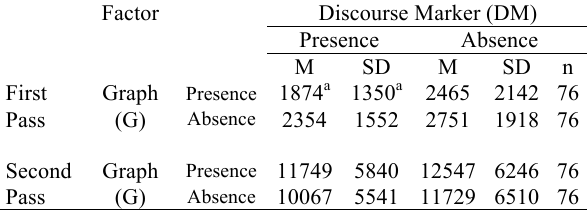
Table 5. Mean and Standard Deviation for First Pass and Se- cond Pass on the consequence segment (S2).